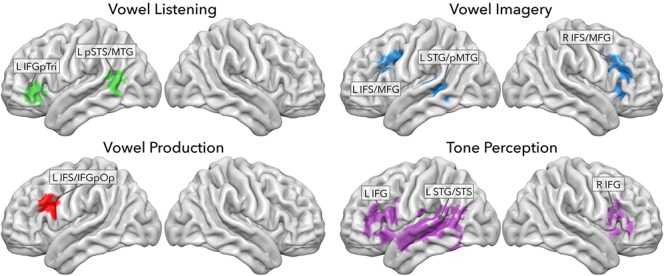
Searchlight classifier results from Rampinini et al. (2017). Each panel shows regions where model-free decoding was successful in each task.